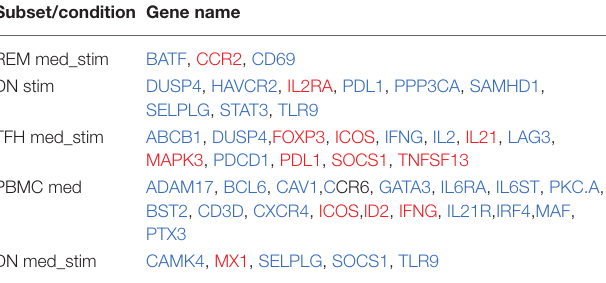
TABLE 5 | List of the genes used to build the five models with the highest prediction accuracy. Subset/condition Gene name